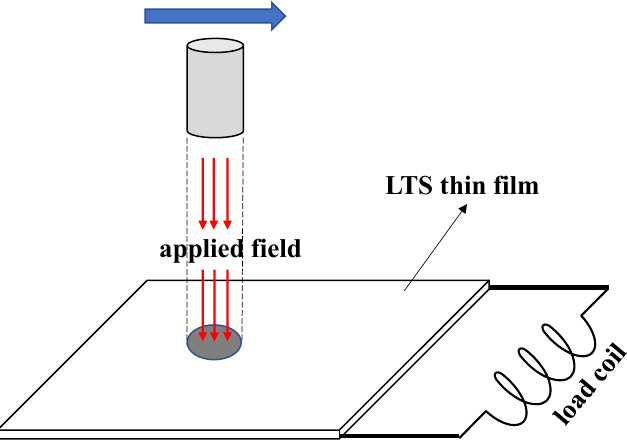
Figure 2. Illustration of magnetic switching for an LTS flux pump.